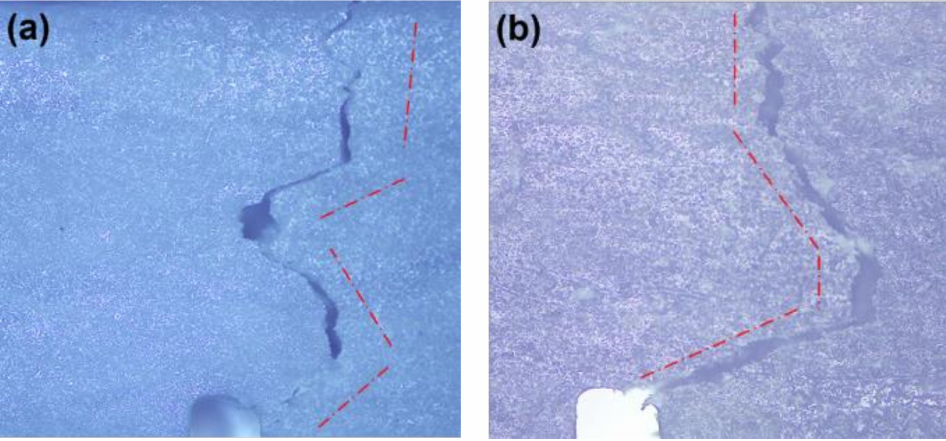
Figure 7. Optical images of crack path, ( a ) A4; ( b )